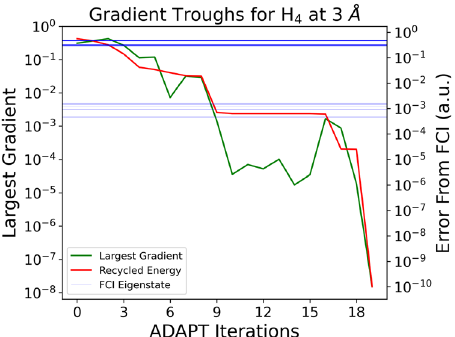
Fig. 7 ADAPT-VQE with recycled parameters for H 4 at 3 Å . The x -axis corresponds to the ADAPT-VQE iteration. The green curve depicts the gradient associated with the operator to be added at each step, while the red curve depicts the energy at each ADAPT- VQE step. The blue lines depict the excited FCI eigenstates which are lower than the HF